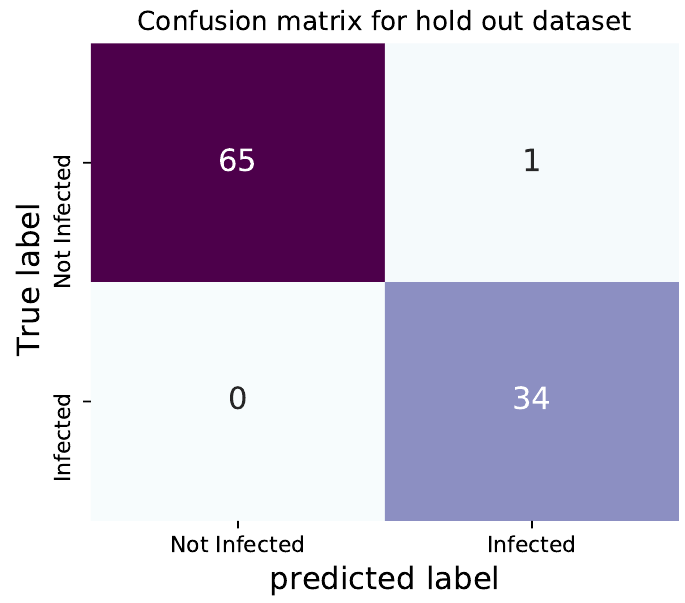
Figure 10. Confusion matrix of testing for hold out X-rays.